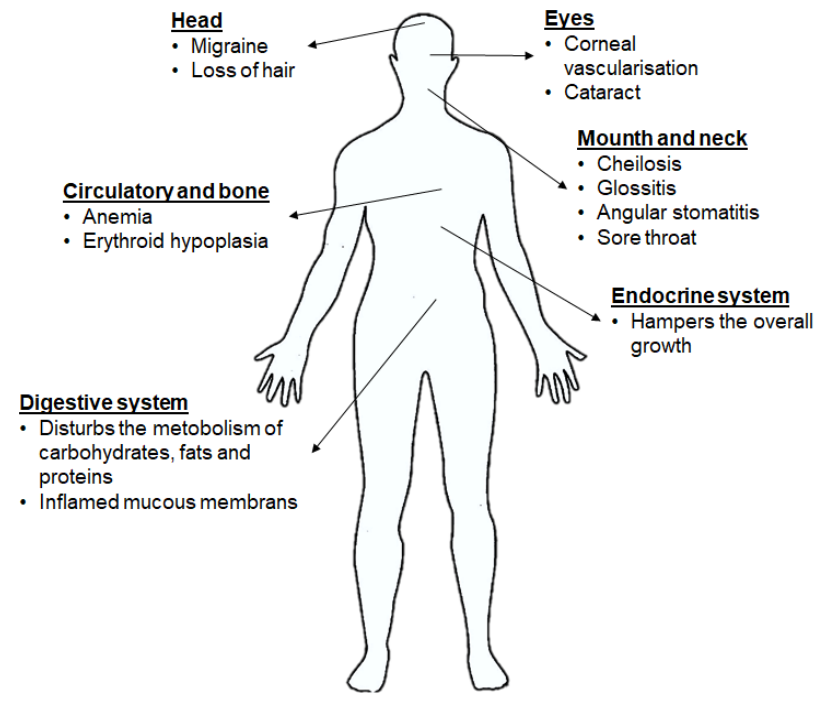
Figure 7. Implications of RF deficiency on health [75].